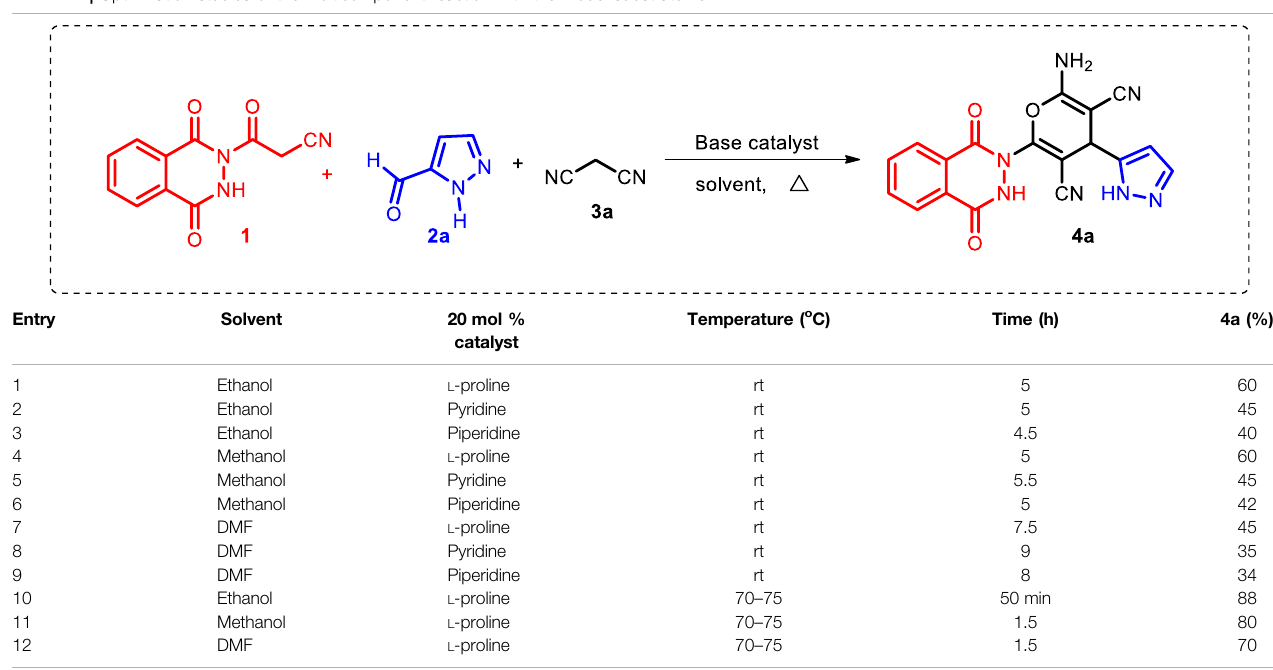
TABLE 1 | Optimization studies of the multicomponent reaction with the model substrate 2a .